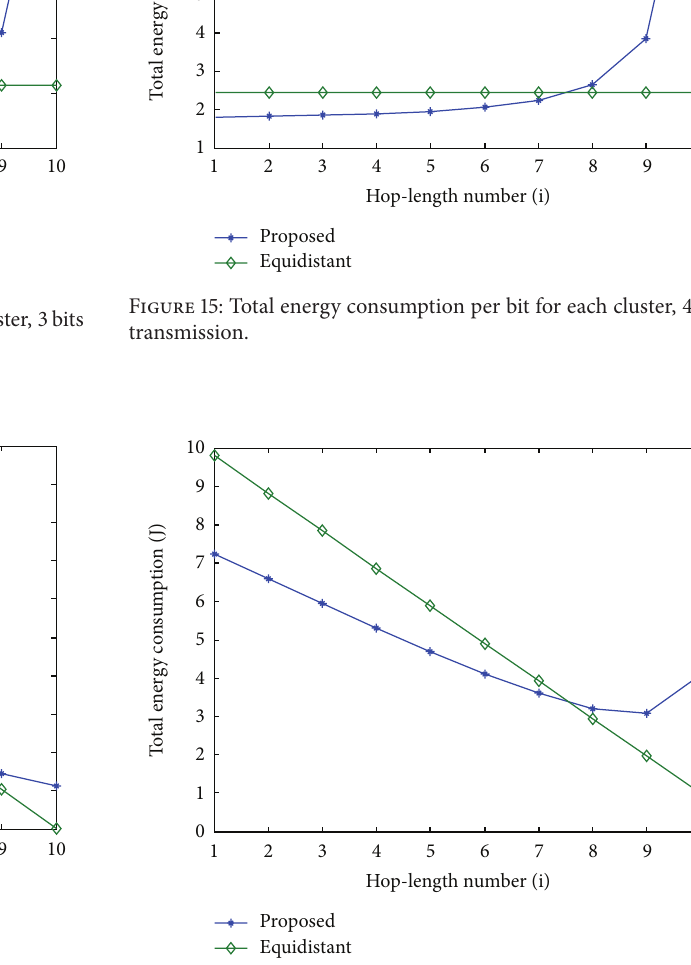
Figure 14: Total energy consumption for each cluster, 3bits trans- mission.